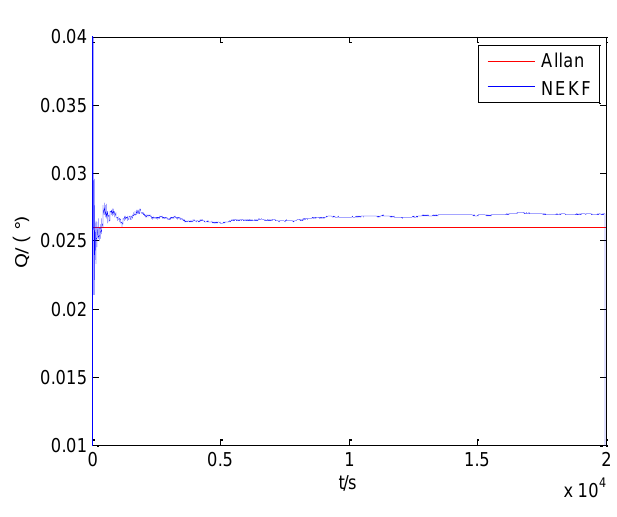
Figure 27. Estimation of R for #1 FOG.